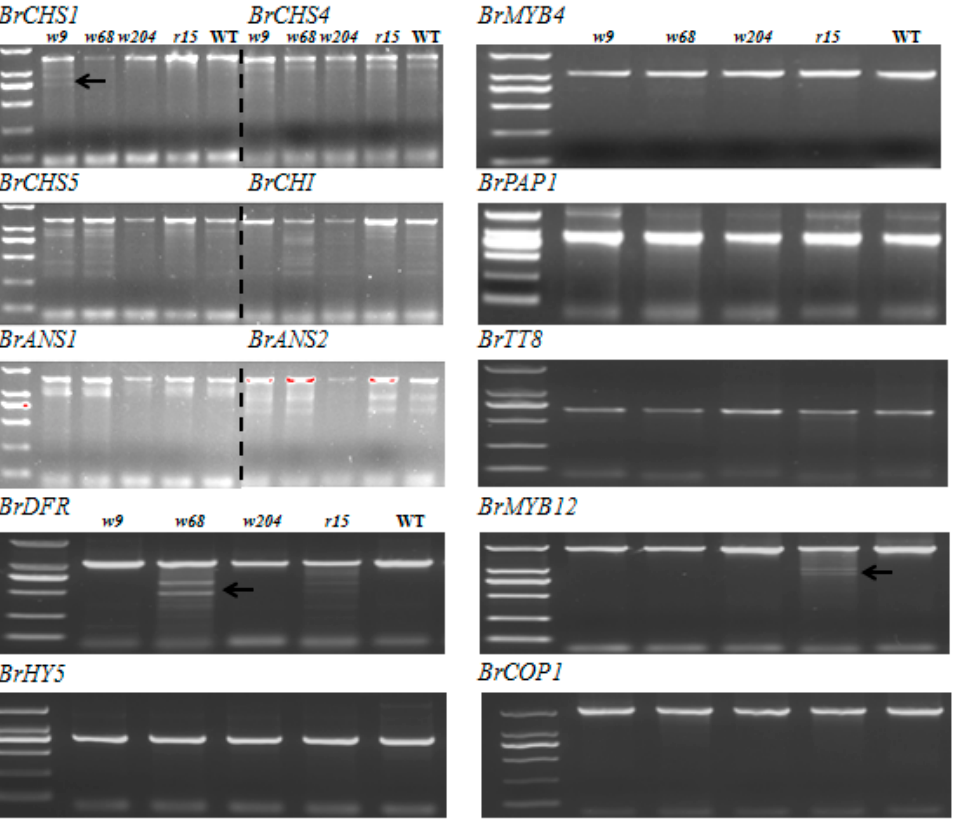
Figure 6. TILLING analysis of anthocyanin biosynthesis genes and light responsive genes in white mutants and red mutants. Each sample was mixed by equal amounts of mutants and WT PCR products via specific primers amplification and digested by Cel I, respectively. Seven mutants ( w9 , w68 , w204 , r15 , r21 , r30 and r37 ) of treated samples were loaded from left to right in 1.5% agarose gel for mutation scanning. Black arrows indicate Cel I-digested fragments.